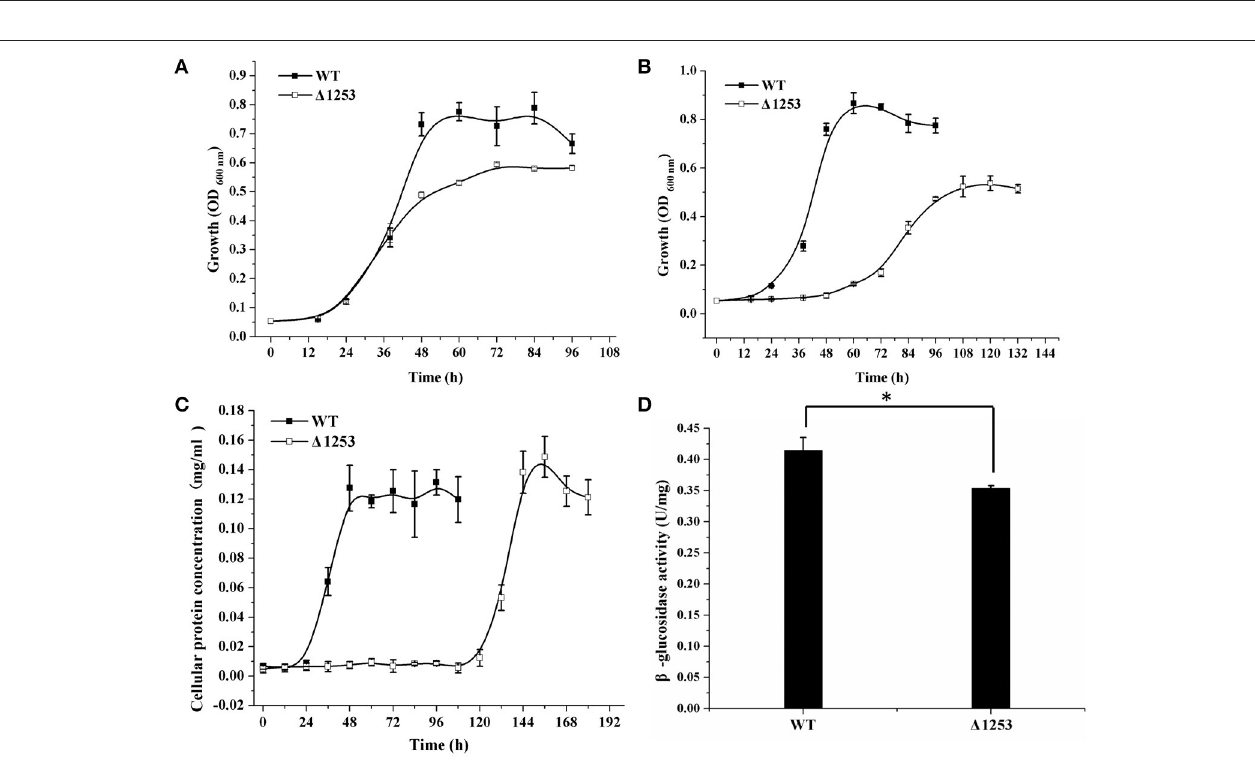
FIGURE 6 | Analyses of growth and β -glucosidase activity of the chu_1253 -inactivated mutant and WT strains. (A) Cell growth on glucose, (B) Cell growth on cellobiose, (C) Cell growth on Avicel, (D) β -glucosidase activity of the intact cells of WT and the mutant strains. Statistical analysis was performed using the student’s t -test analysis. Significant differences ( T- test * P < 0.05) in the enzymatic activities were detected. Values in this figure are the mean of three to five biological replicates. Error bars are the SD from these replicates.